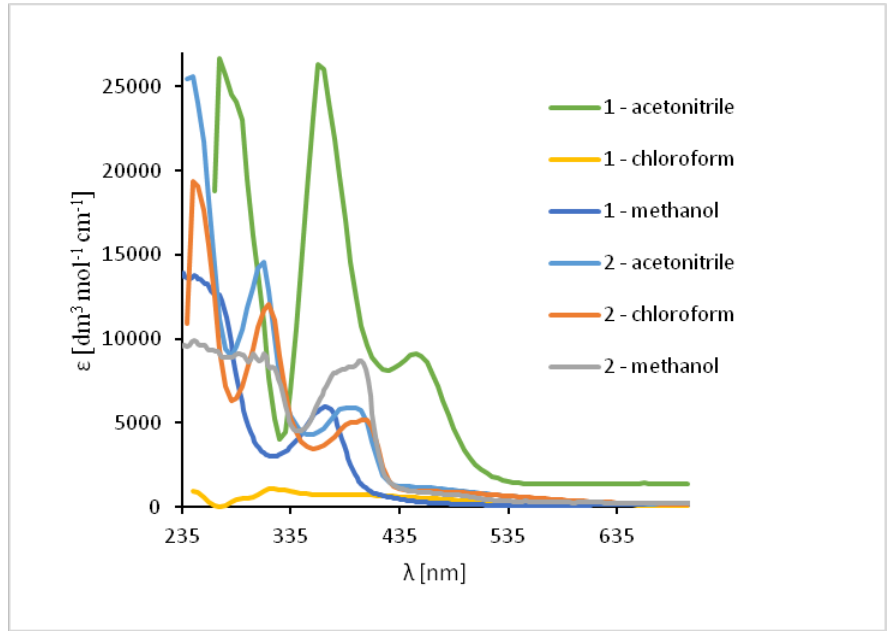
Figure 9. Solution absorption spectra of complexes in chloroform, acetonitrile and methanol, 1 × 10 − 4 mol / dm 3 ,